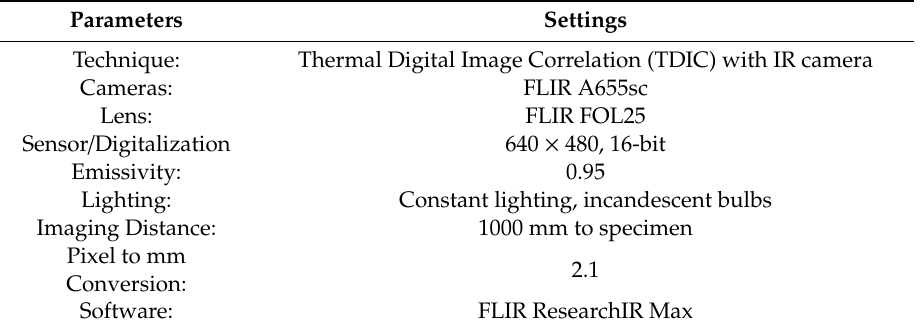
Table 4. FLIR infrared (IR)